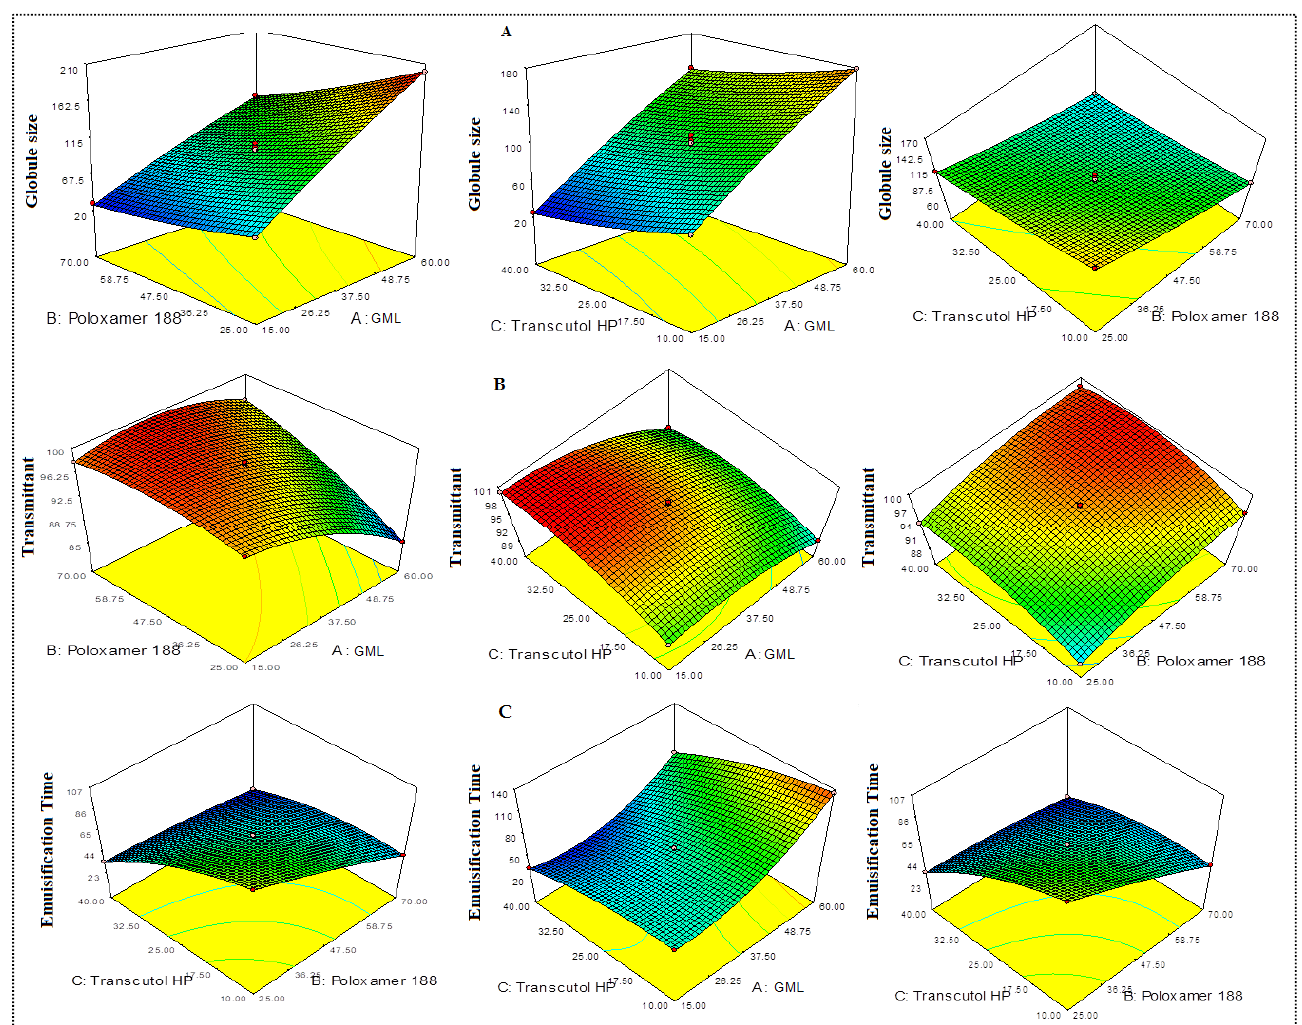
Figure 2. 3D response surface plot showing the effect of independent variables on the globule size ( A ), transmittance (%) ( B ), and emulsification time ( C ).